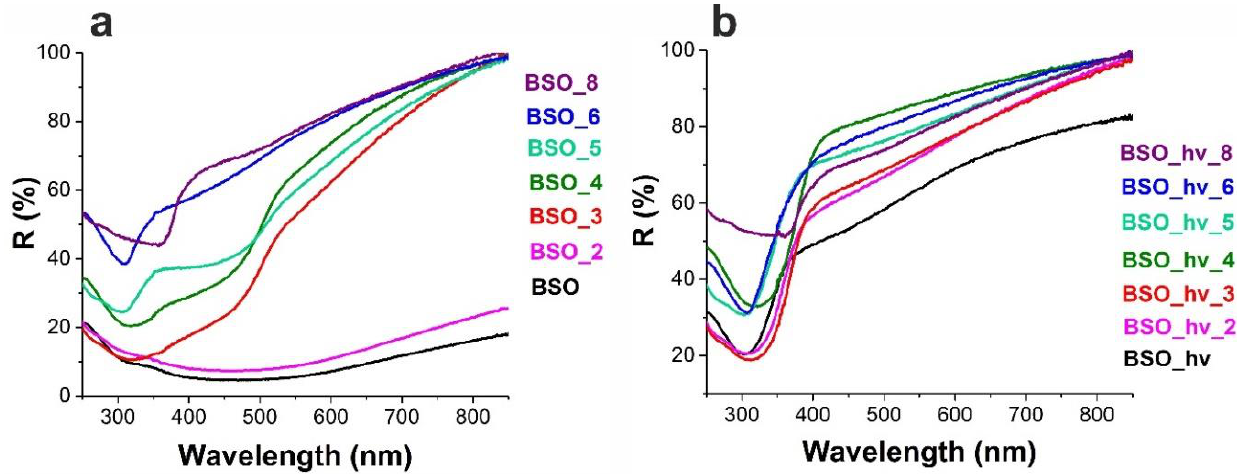
Figure 7. DRS of the BSO ( a ) and BSO_hν ( b ) groups of materials. Samples BSO_3 and BSO_4